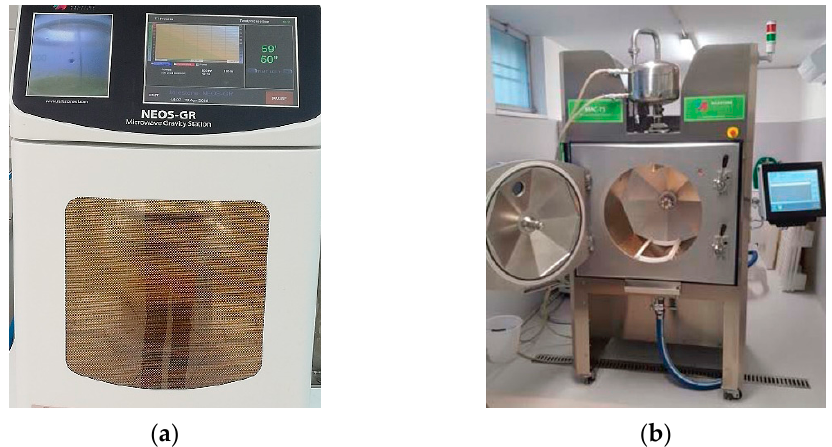
Figure 4. ( a ) Lab scale and ( b ) industrial scale of microwave-assisted extractors.